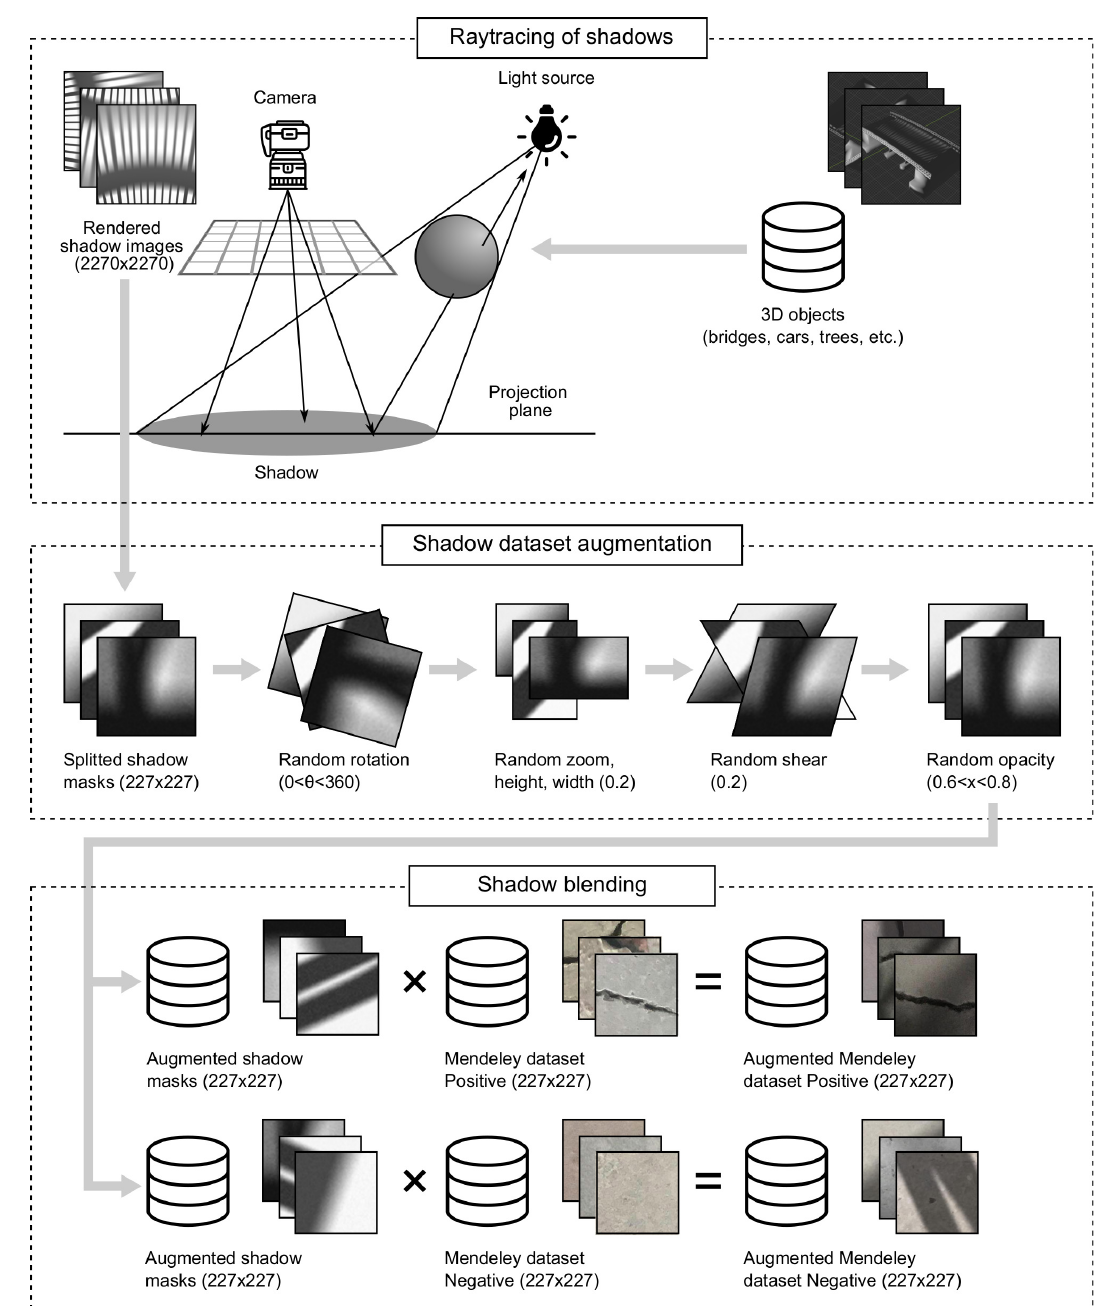
Figure 4. A schematic diagram for synthetic augmentation of complex shadow patterns—ray-tracing of shadows, shadow data set augmentation, and shadow